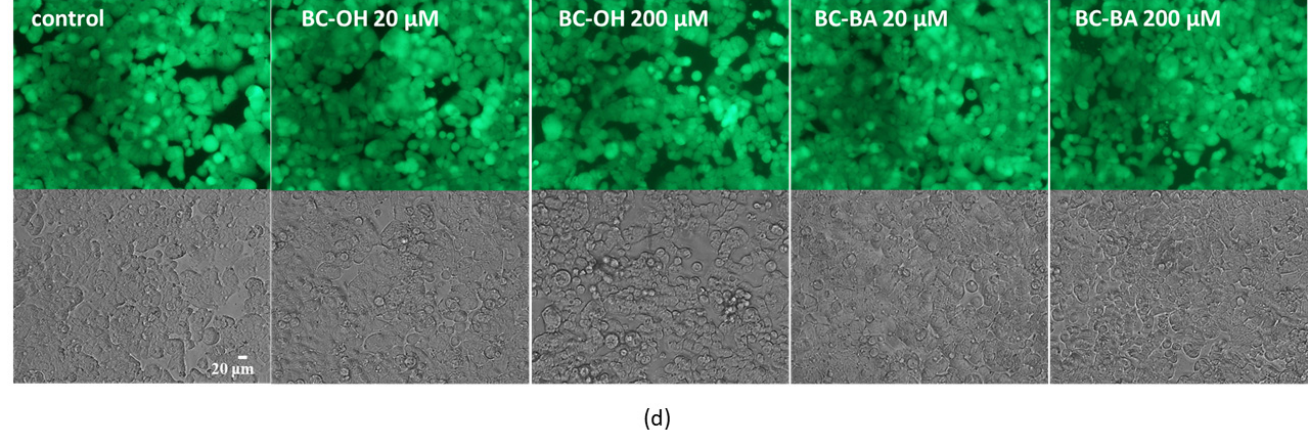
Figure 7. The influence of BC-OH ( a ) and BC-BA ( b ) on HT29 cell metabolic activity, determined by MTT assay after 8 h exposure; control cells were not exposed to any compound but the vehicle (EtOH/DMSO (9:1) ( c ); values are means ± SEM, n ≥ 7; statistical significance was calculated versus control cells (untreated), * p ≤ 0.05, ** p ≤ 0.01. Morphology of HT29 cells stained with 2 µM calcein AM observed after incubation with 20 and 200 µM of BC-OH and BC-BA ( d ); randomly chosen fields were photographed at × 200 with fluorescent microscope Nikon TS Eclipse 100.